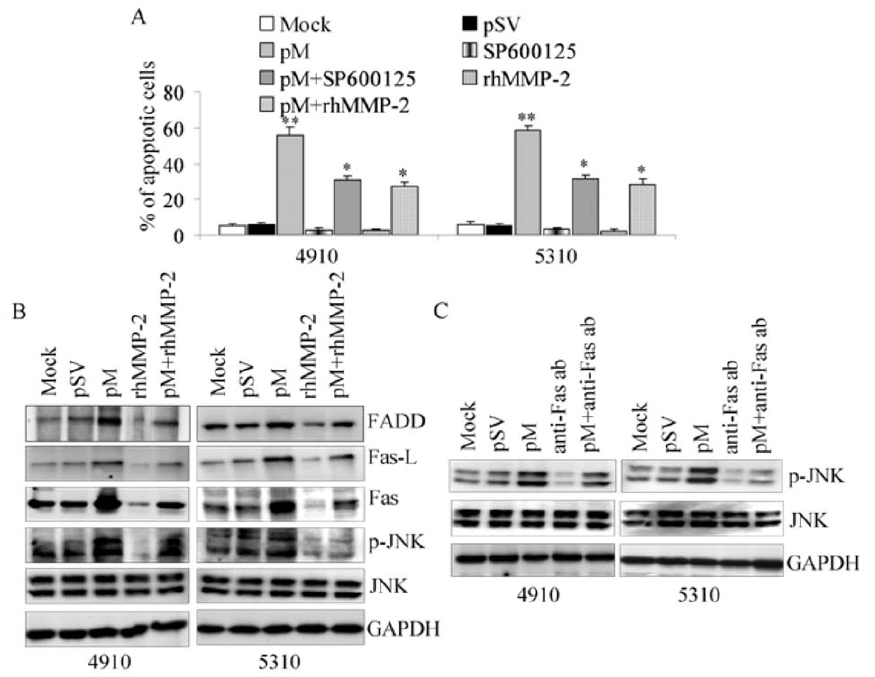
Figure 7. A. Effect of JNK inhibitor (SP600125) and recombinant human MMP-2 (rhMMP-2) treatment on pro-apoptotic effect of MMP-2 downregulation. The number of TUNEL positive cells were scored in randomly selected microscopic fields at the end of various treatments as described in Materials and Methods. The percentage of apoptotic cells in each treatment was plotted in bar diagrams with mean 6 SE and significant difference among various treatment groups was represented by ‘‘*’’, at p , 0.05 and ‘‘**’’, at p , 0.01 in three individual repetitions. B. Effect of rhMMP- 2 treatment on pM induced FADD, Fas, Fas-L and pJNK expression. The whole cell lysates from different treatments were subjected to Western blotting. C. Role of Fas in pM induced JNK activation. The Fas/Fas-L function was blocked by using neutralizing antibody against Fas in the individual treatments. At the end of 60 h transfection, anti-Fas ab (250 ng/ml) was added and cells were further incubated for another 12 h at the end of which whole cell lysates were prepared and subjected to Western blotting to determine the effect of Fas/Fas-L functional blocking on JNK phosphorylation. The blots are representative of three individual experiments.